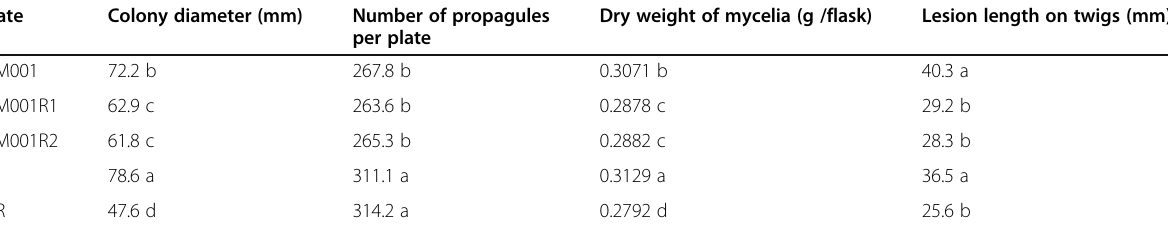
Table 3 Comparison of mycelial growth, number of propagules, dry weight of mycelia and pathogenicity between PR mutants and their parental isolates Isolate Colony diameter (mm)